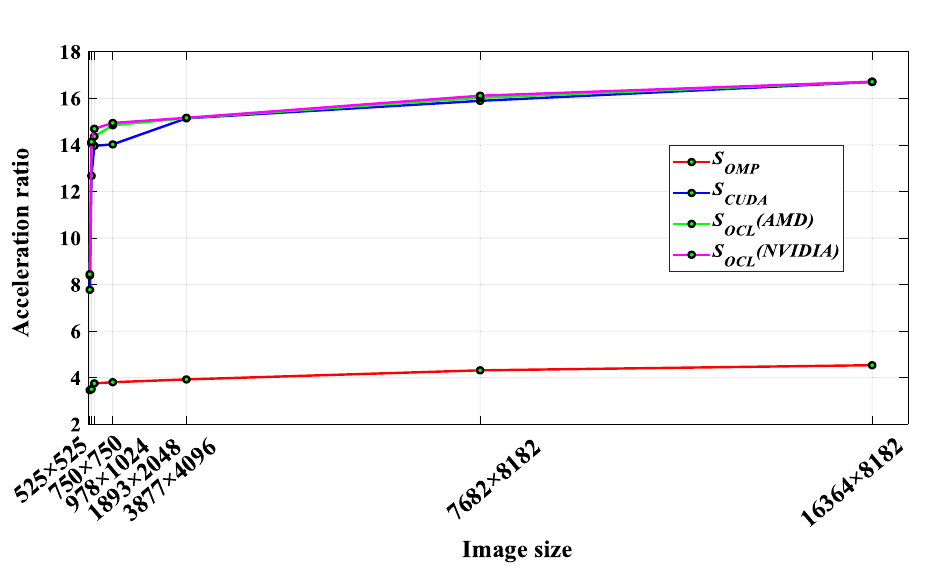
Figure 8. Speedup of parallel algorithms on four